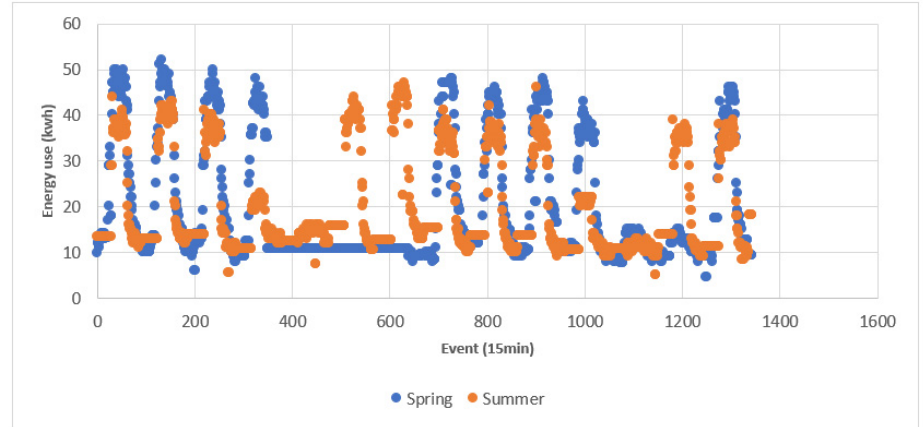
Figure 23. A two-week comparison of spring and summer energy use.